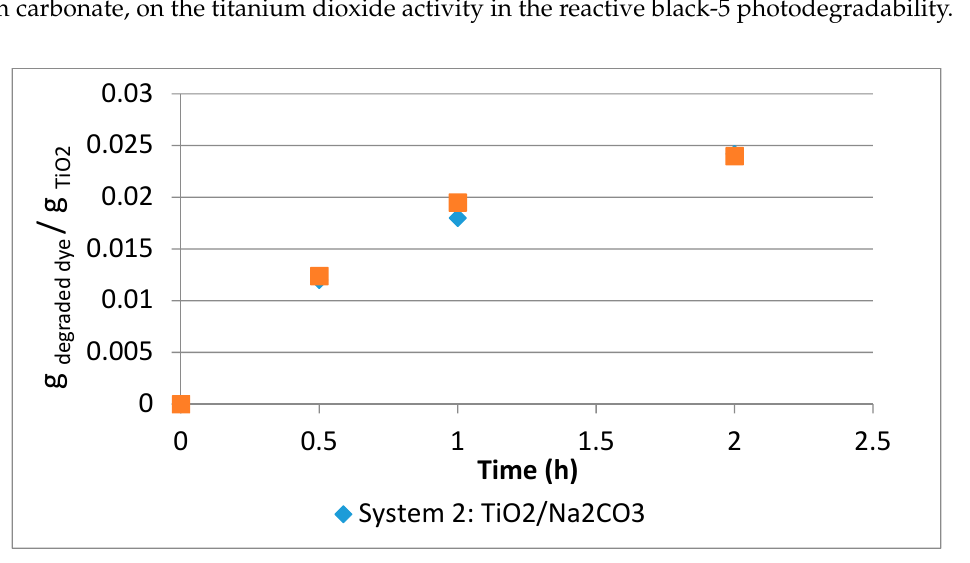
Figure 14. Variation of the color solution for System 5, as a function of the UV irradiation time exposure.